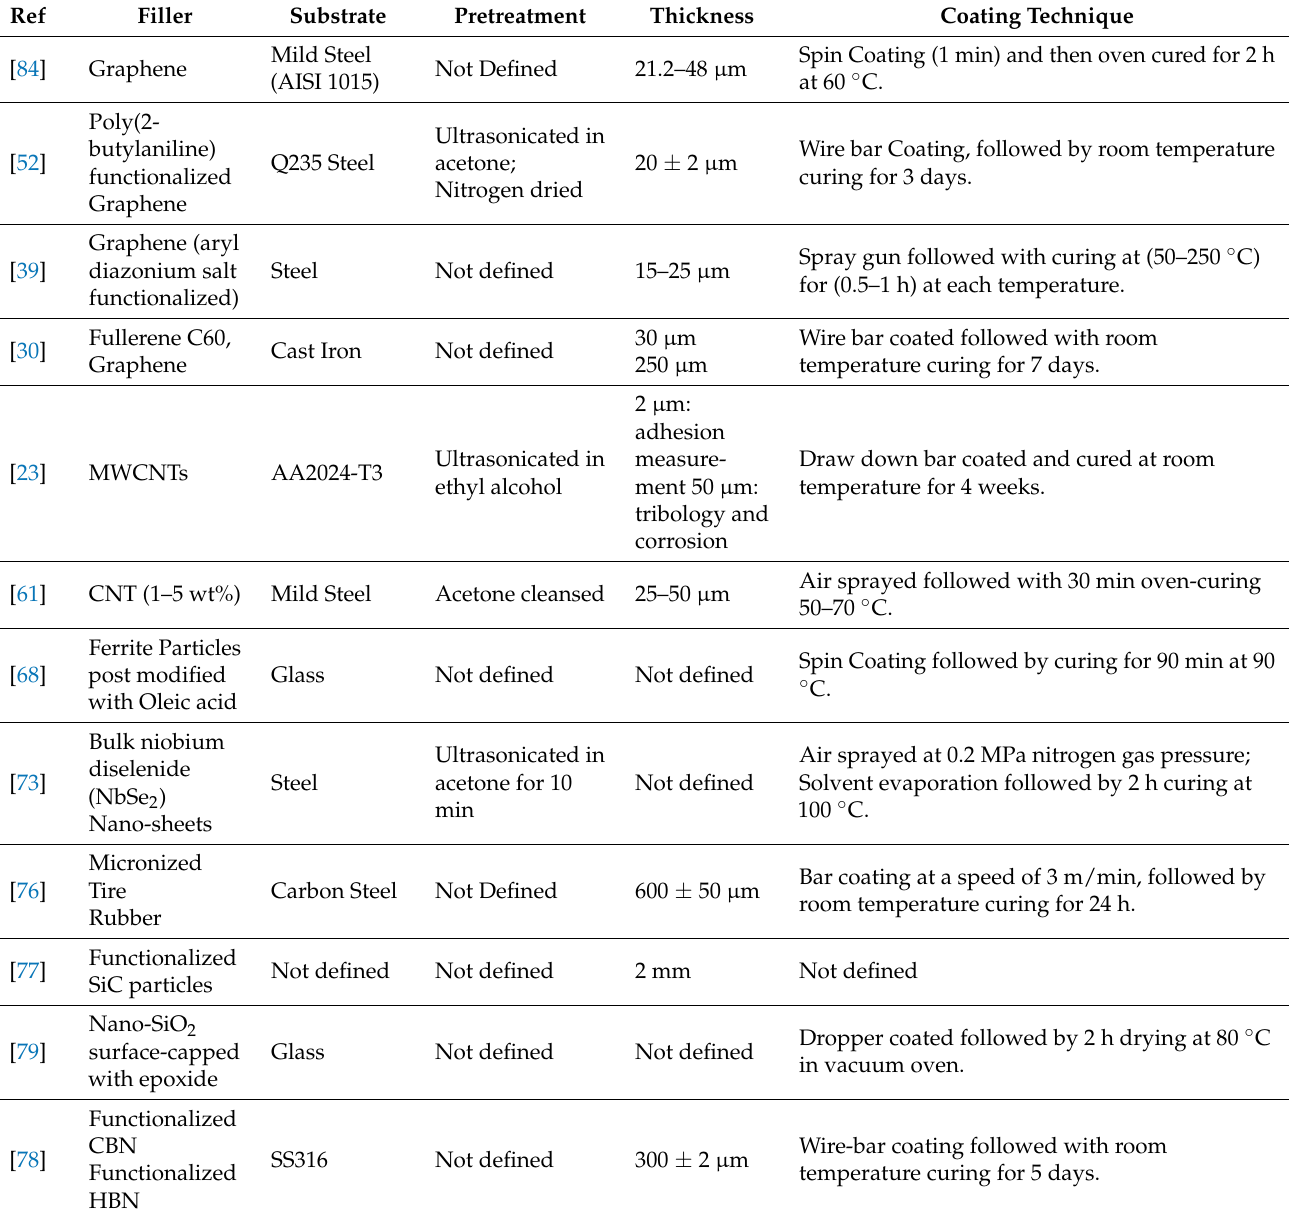
Table 4. Different types of coating techniques and pre-treatment techniques used by